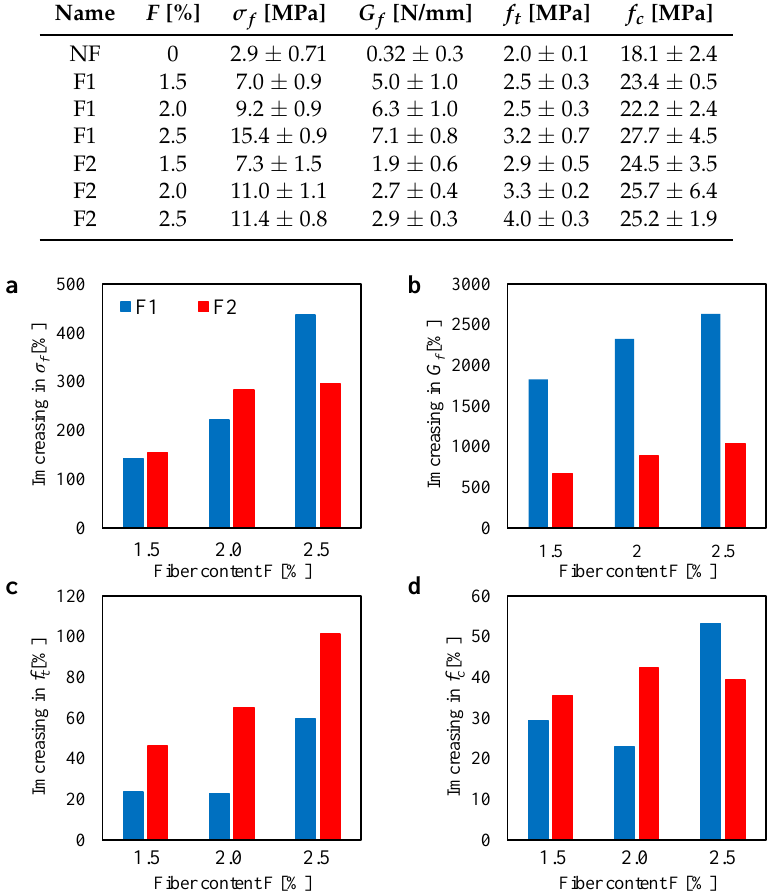
Table 2. Mechanical properties of the lime-based mortar reinforced by two types of short-fibers (F1 and F2) with different fiber content F .